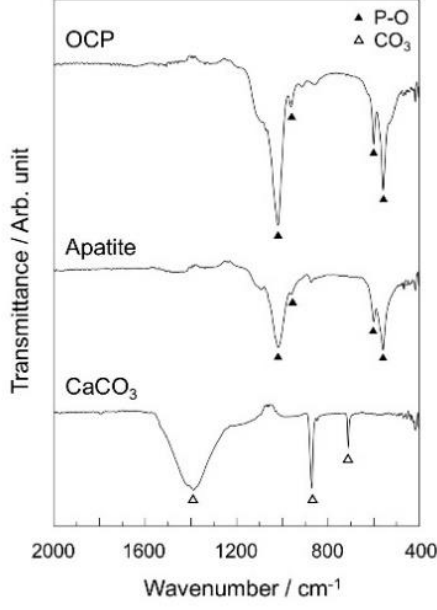
Figure 3. FT-IR spectra of the OCP, apatite, and calcite microspheres. Figure 4 shows the adsorption isotherm of the apatite and OCP microspheres. In the case of apatite, the shape of the isotherm was categorized as Type IV according to the International Union of Pure and Applied Chemistry (IUPAC) classification, suggesting the existence of 2 to 50 nm mesopores. Hysteresis was observed at a relative pressure of 0.5 to 1.0, also suggesting the existence of mesopores. The shape of the hysteresis was categorized as a combination of Type H3 and H4 of the IUPAC classification. Type H3 indicates the presence of slit-type pores and aggregates of plate-like particles, and Type H4 indicates the presence of micropores smaller than 2 nm.